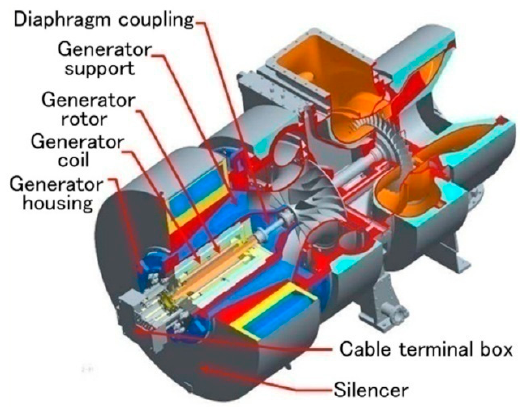
Figure 1. Cross-sectional view and main Electric Motor-Generator (EM-G) components of the hybrid turbocharger [25].